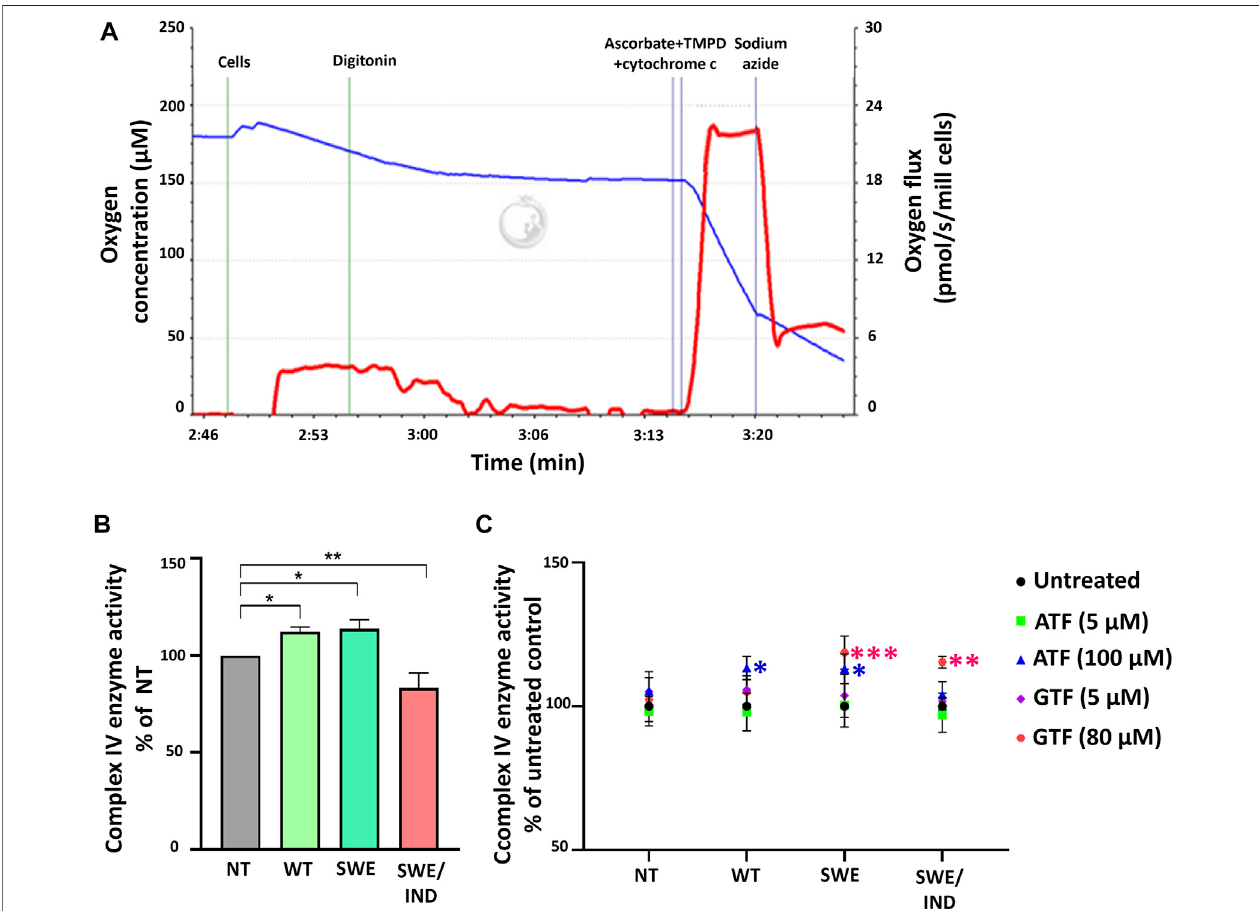
FIGURE 4 | Analysis of complex IV enzyme activity by high-resolution respirometry. (A) Qualitative data of complex IV enzyme activity were recorded after the addition of ascorbate, TMPD and cytochrome c expressed as the oxygen fl ux (pmol/s/mill cells) with chemical background correction using the value recorded after the addition ofsodium azide. (B) ThelevelofcomplexIVenzymeactivity inSH-SY5Y cellsoverexpressingdifferenttypes ofAPP(WT,Swe,and Swe/Ind) expressed as%of thenontransfected SH-SY5Y controlcells(NT).*: p < 0.05,**: p < 0.01. (C) Effects ofATFand GTF treatment oncomplexIVenzymeactivity innontransfectedSH- SY5Y (NT) and cells overexpressing different types of APP (WT, Swe, and Swe/Ind) expressed as % of the untreated group in respective type of cells. *: p < 0.05, **: p < 0.01, *** p < 0.001. Data are expressed as the mean ± SD, (N (cid:1) 3).